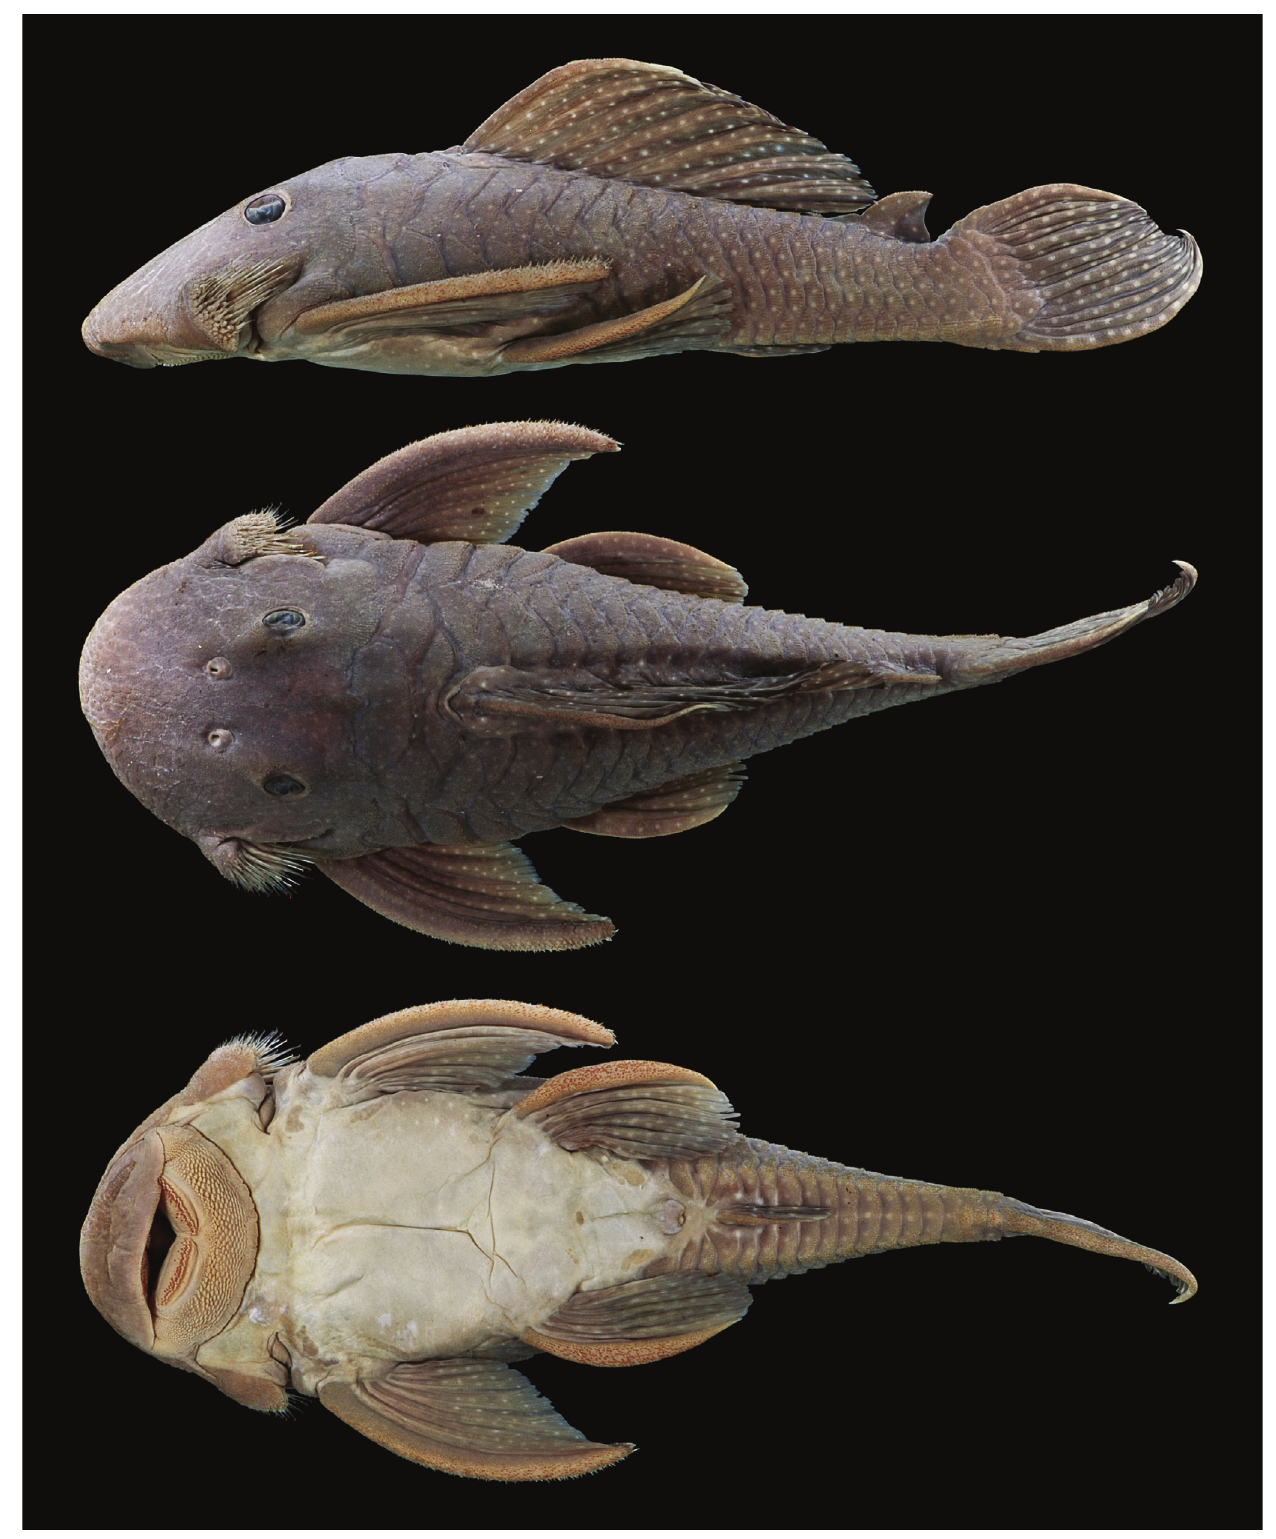
Fig. 1. Baryancistrus xanthellus , INPA 33849, holotype, 214.2 mm SL in lateral, dorsal, and ventral views (photos RRO). Brazil, Pará, Senador José Porfírio, rio Xingu in the vicinity of the cachoeira Buraco do